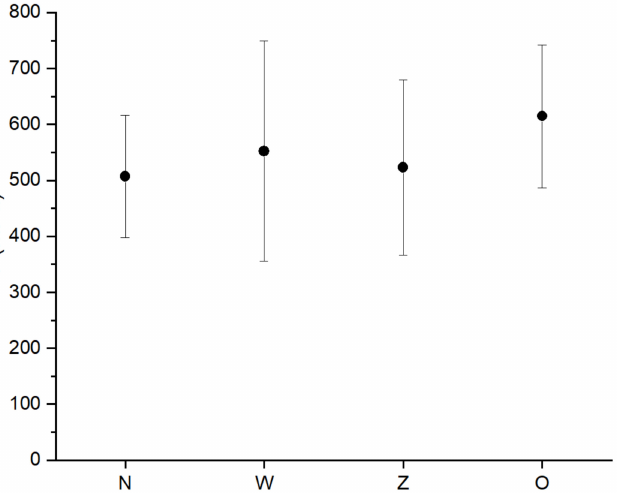
Figure 3. Graph of the averaged Young’s pseudo-modulus of elasticity. The black dot means mean